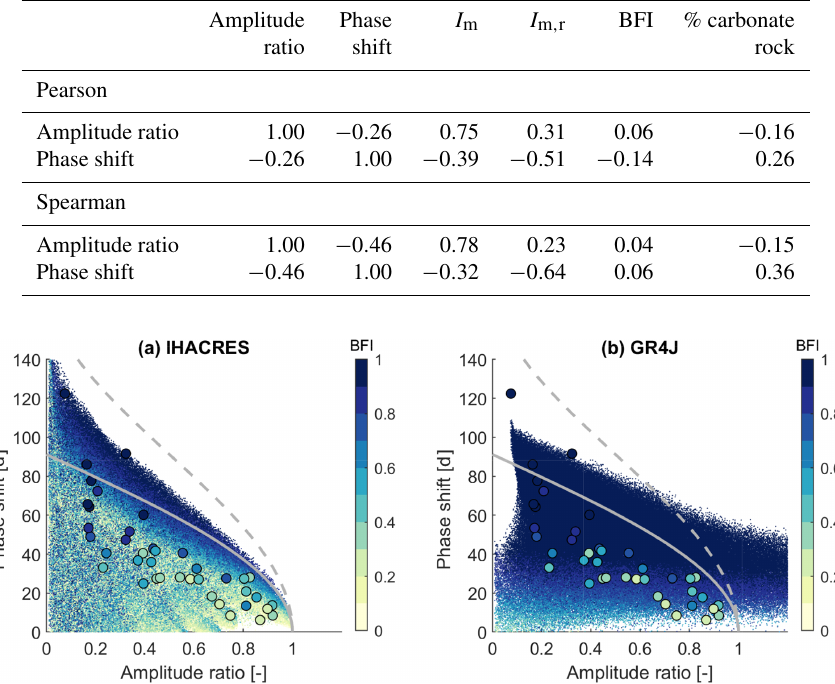
Figure 8. Amplitude ratio against phase shift for 40 catchments in the UK using 20000 parameter sets each for (a) IHACRES and (b) GR4J. The large dots show the observed signatures of the 40 catchments used for the modelling experiment. Colours indicate the BFI. Note that both axes are